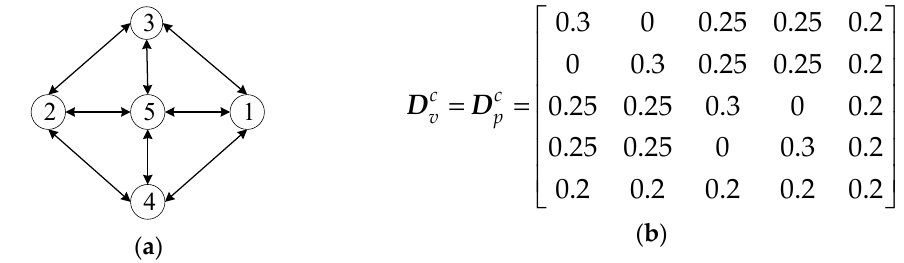
Figure 15. Common topology and the corresponding matrix D c . ( a ) the common topology; ( b ) the corresponding matrix. Energies 2020 , 13 , x FOR PEER REVIEW